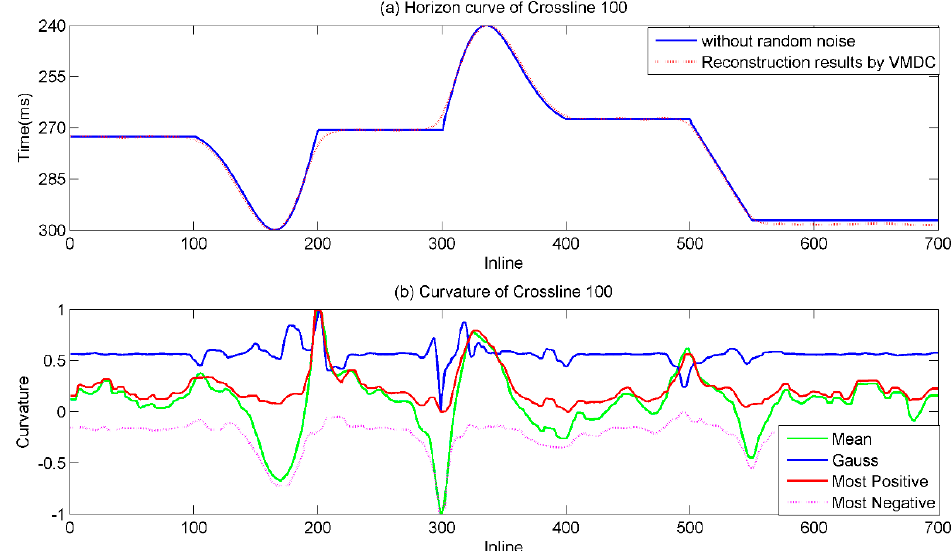
Figure 14. Horizon curve and curvature attributes: ( a ) Reconstruction results of horizon curve by VMDC and ( b ) curvature attributes after denoising based on VMDC.